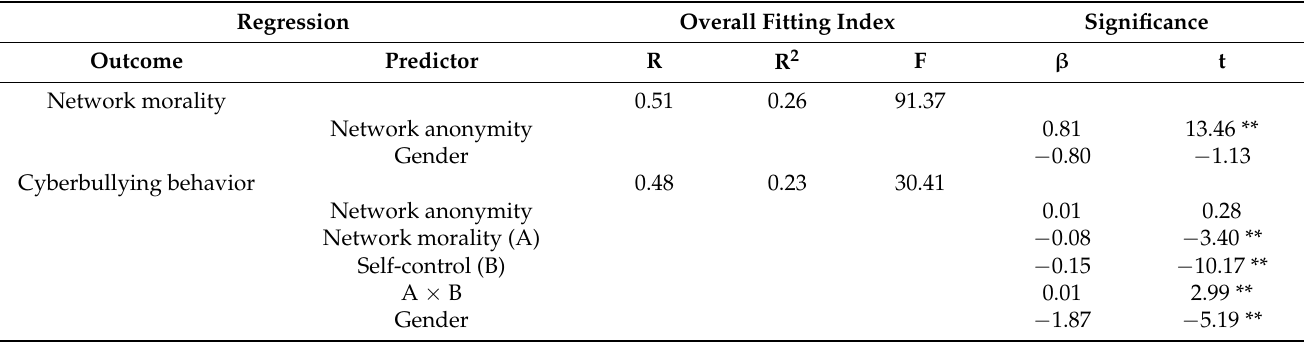
Table 3. Moderated mediation model.